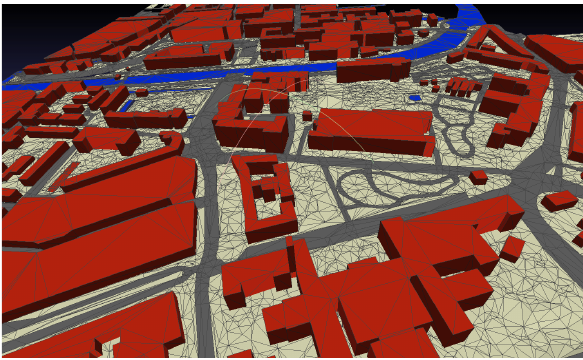
Figure 12 3D IMGeo data, automatically reconstructed from 2D IMGeo data and height